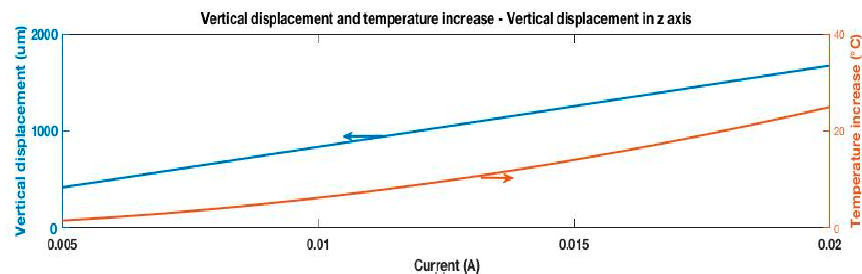
Figure 3. Results of simulated micro-mirror when vertically moving up in z